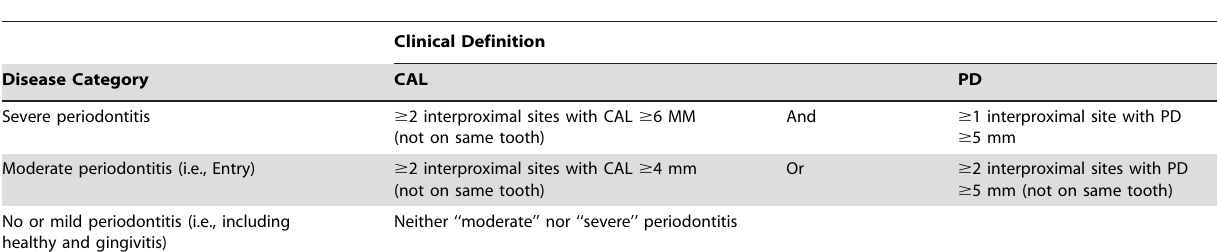
Table 2. Periodontal Disease Severity defined by clinical parameters.